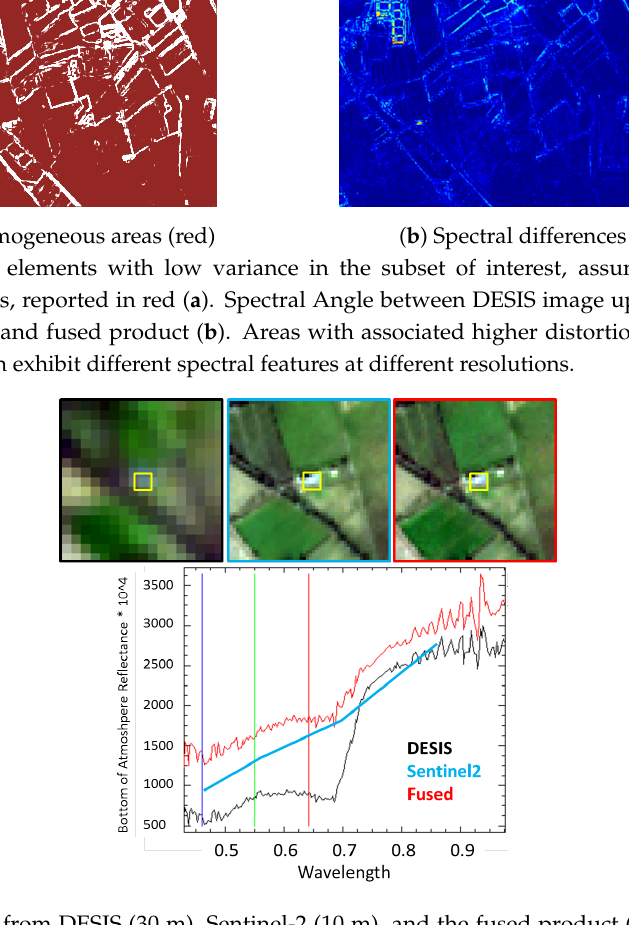
Figure 30. Subsets from DESIS (30 m), Sentinel-2 (10 m), and the fused product (10 m). Below are reported the relative spectra for the center of the yellow squares in the image subsets. The Sentinel-2 spectrum, corresponding to a man-made object, shows a high reflectance in the red spectral range: this is not observable in the larger DESIS pixel, dominated by vegetation. The fused product (10 m) correctly synthesizes a full spectrum resembling the general behavior of the Sentinel-2